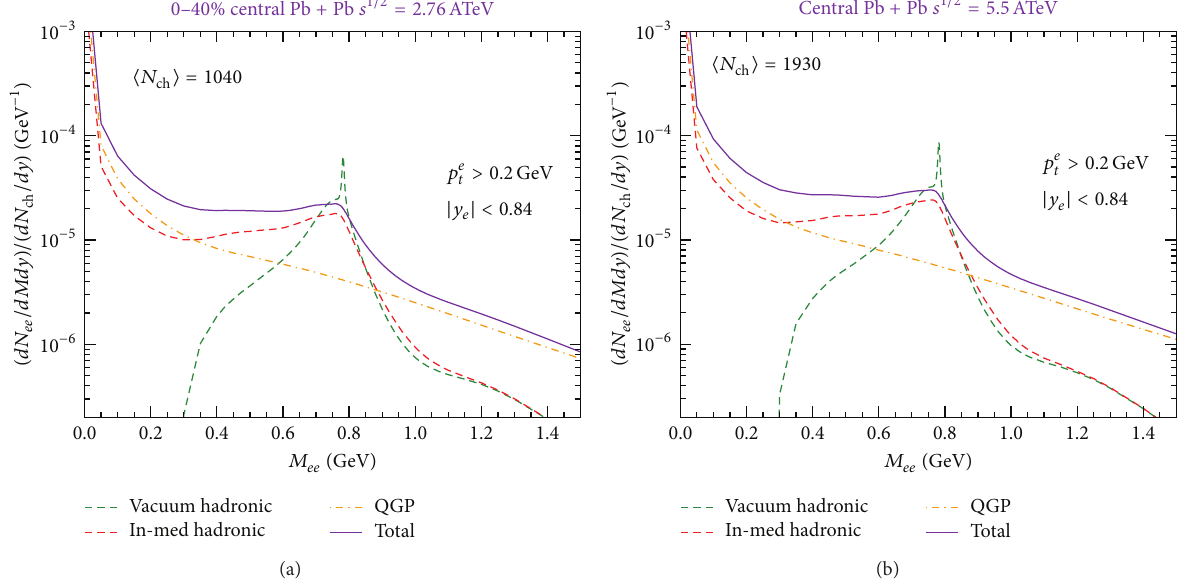
Figure 10: Dielectron invariant-mass spectra from thermal radiation in 0–40% central Pb-Pb(2.76 ATeV) (a) and 0–10% central Pb- Pb(5.5 ATeV) (b), including single-electron cuts to simulate the ALICE acceptance. Hadronic (with in-medium or vacuum EM spectral function) and QGP contributions are shown separately along with the sum of in-medium hadronic plus QGP. Here and in the following LHC plots, both vacuum and in-medium hadronic emission rates in the LMR have been supplemented with the vacuum spectral function in the LMR; that is, no in-medium effects due to chiral mixing have been included (for all RHIC calculations shown in the previous sections, full chiral mixing was